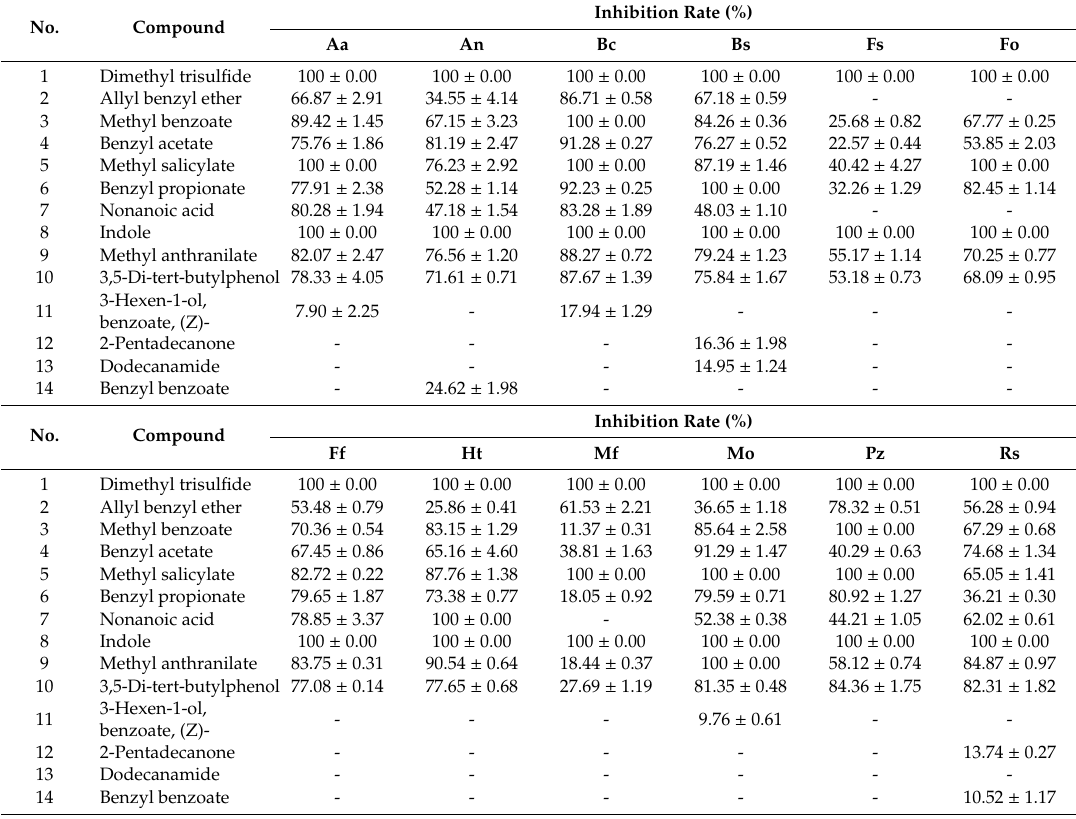
Table 1. Mycelial growth of plant fungal pathogens exposed to 14 pure standards after 10